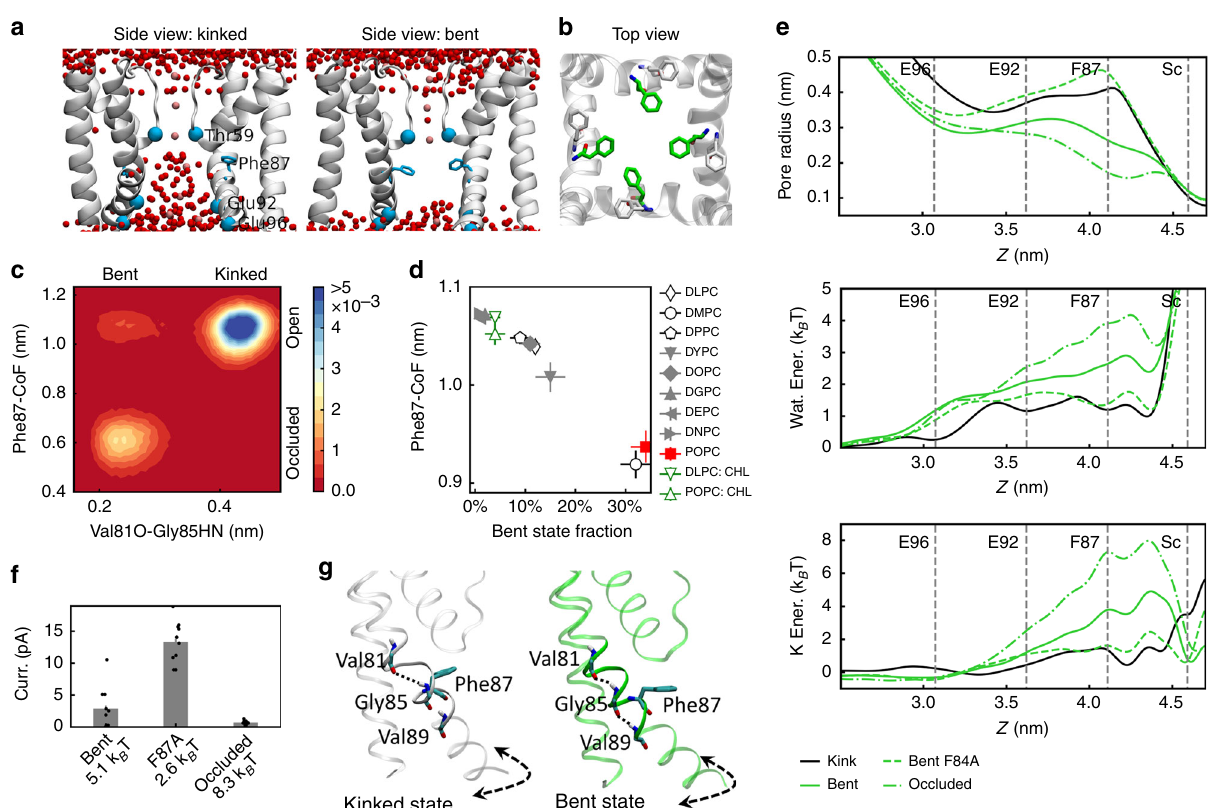
Fig. 5 Gating of the central cavity by the kink of the inner helix. a Different Phe87 side-chain orientations in the kinked (left half) and bent (right half) states result in different hydration degrees of the central cavity. Water molecules and potassium ions are shown as red and pink spheres, respectively. Phe87 is shown as cyan stick model. C α atoms of Thr59, Glu92, and Glu96 are shown as cyan spheres. b Top view of Phe87 side-chain orientation in the kinked (white) and bent (green) state. The inner helices are also shown in white. c Histogram as a function of the Val81O – Gly85HN distance and the Phe87-CoF distance (result of simulations in POPC membranes). d Phe87-CoF distance as a function of the bent-state fraction. e Pore radius (top), “ free energy ” pro fi les of water (middle), and potassium (bottom) in simulations with different dehydration degrees of the central cavity. Results of the kinked state, the bent state, the bent state including the Phe87Ala mutation, and the occluded state are shown. Positions of Glu96, Glu92, and Phe87, as well as the Sc site, are indicated by gray dashed lines. f Average ion currents of the simulations depicted in panel ( e ). The “ energy barrier ” of potassium in each simulation is indicated in the text label. The Thr59 O γ – O γ distance is ~0.53 nm for all simulations. Results of the kinked state are not shown due to a different opening degree of the selectivity fi lter. Ion currents of the simulation replicates are shown as black dots. Each data point includes 10 independent replicates. g Representative conformations of the inner helix surrounding the open (kinked, white) and closed (bent, green) central cavity. Critical backbone hydrogen bonds are indicated by dotted lines. Dashed arrows indicate the rotation direction of the inner helix. Data are presented as mean values ± SEM. Source data are available as a Source Data fi